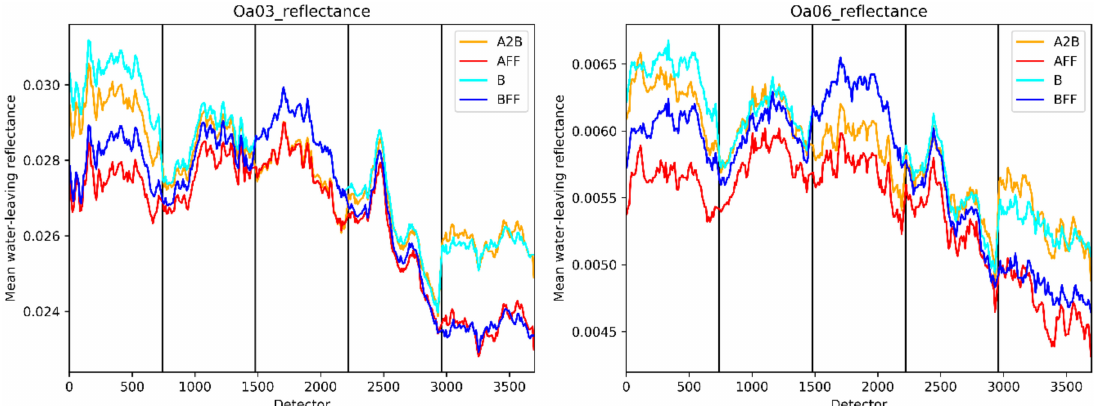
Figure 24. ALT-averages of water-leaving reflectance at Oa03 (443 nm, left ) and Oa06 (560 nm, right ) over SPG for the four calibration